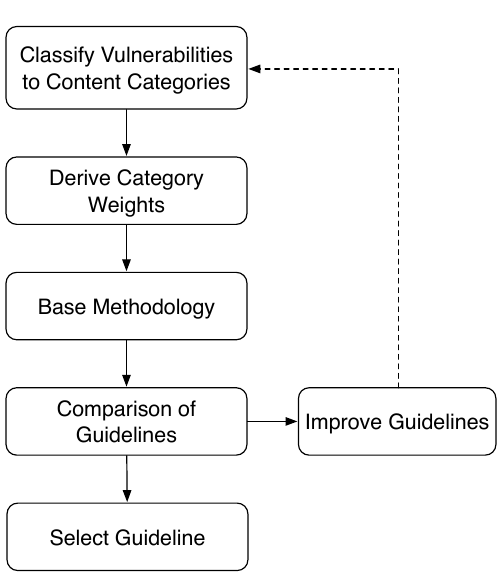
Figure 7. Extended